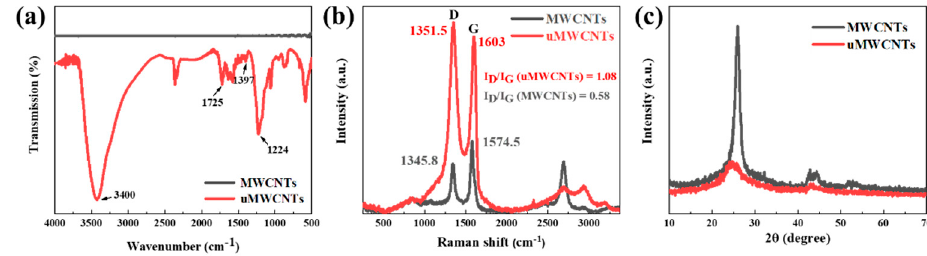
Figure 3. FTIR spectra ( a ), Raman spectra ( b ) and XRD patterns ( c ) of MWCNTs and uMWCNTs.